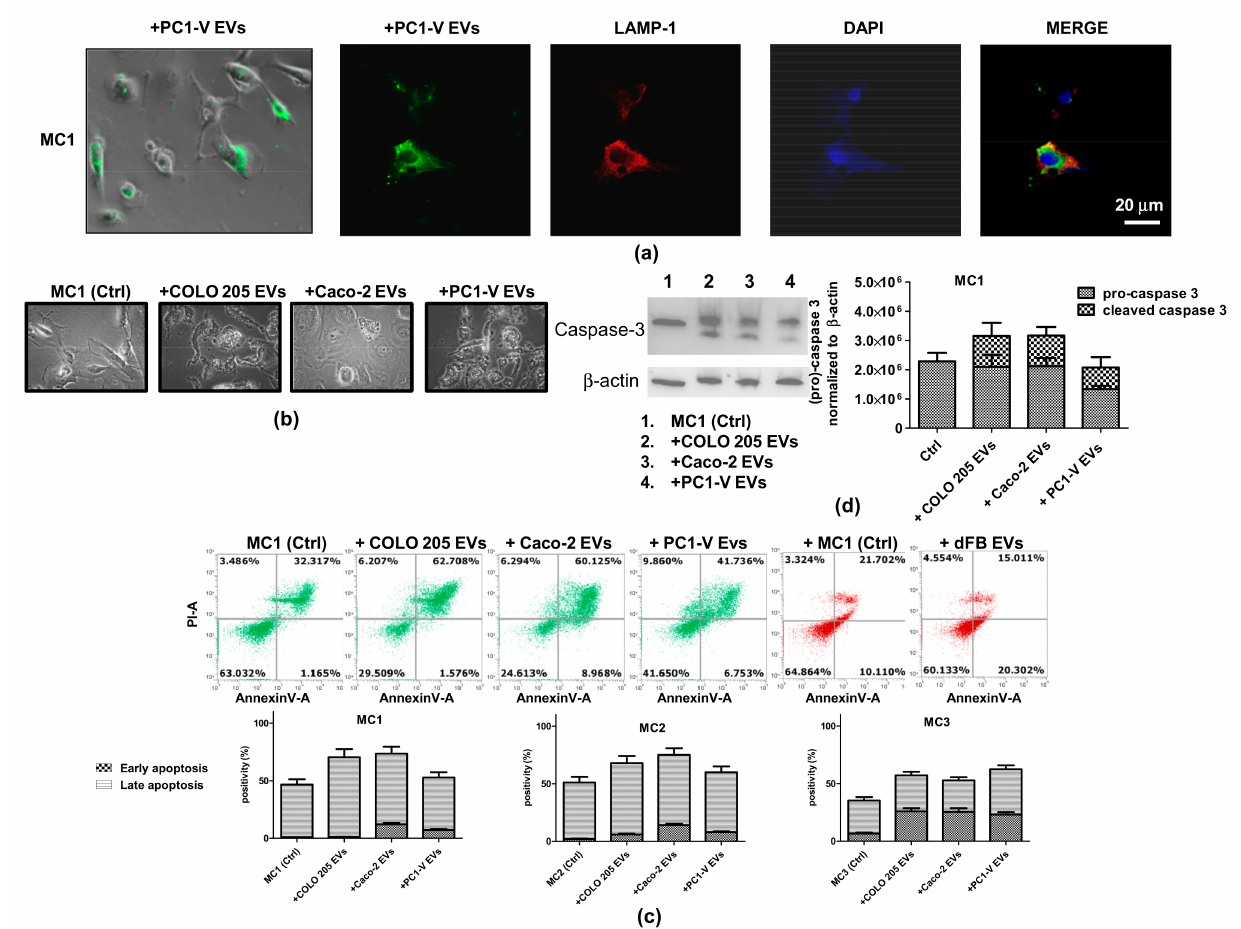
Figure 4. Uptake of tumor-EVs changes the morphology of mesothelial cells and causes their apoptosis. ( a ) Representative images of fluorescence and phase-contrast microscopy showing internalization of fluorescent PKH67-PC1-V EVs (green) in the MC1 cell line (magnification × 400) and representative images of fluorescence confocal microscopy showing PKH67-MC EVs uptake and colocalization with LAMP-1 (red) in PC1-V cells (magnification × 1000). ( b ) Representative images of optical microscopy showing the morphology of MC1 cells before (Ctrl) and after adding tumor EVs. ( c ) FCM dot plots of AnnexinV/PI positive MC1 cells before and after adding COLO 205 EVs, Caco-2-EVs, and PC1-V EVs and histogram plots depicting the % of early and late apoptosis. Each value reported in the histograms is the mean ± SD of three different experiments. FCM dot plots of AnnexinV/PI positive MC1 cells before and after adding dFB EVs are shown as the non-tumor model. ( d ) Representative immunoblots and quantification showing the increase in cleaved caspase-3 expression in MC1 cells treated with COLO 205 EVs, Caco-2 EVs, and PC1-V EVs. β -actin is used as a